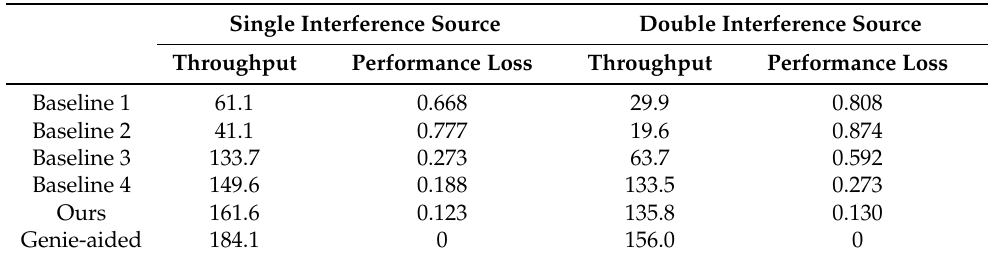
Table 4. The throughput and performance loss of different methods in the prototyping